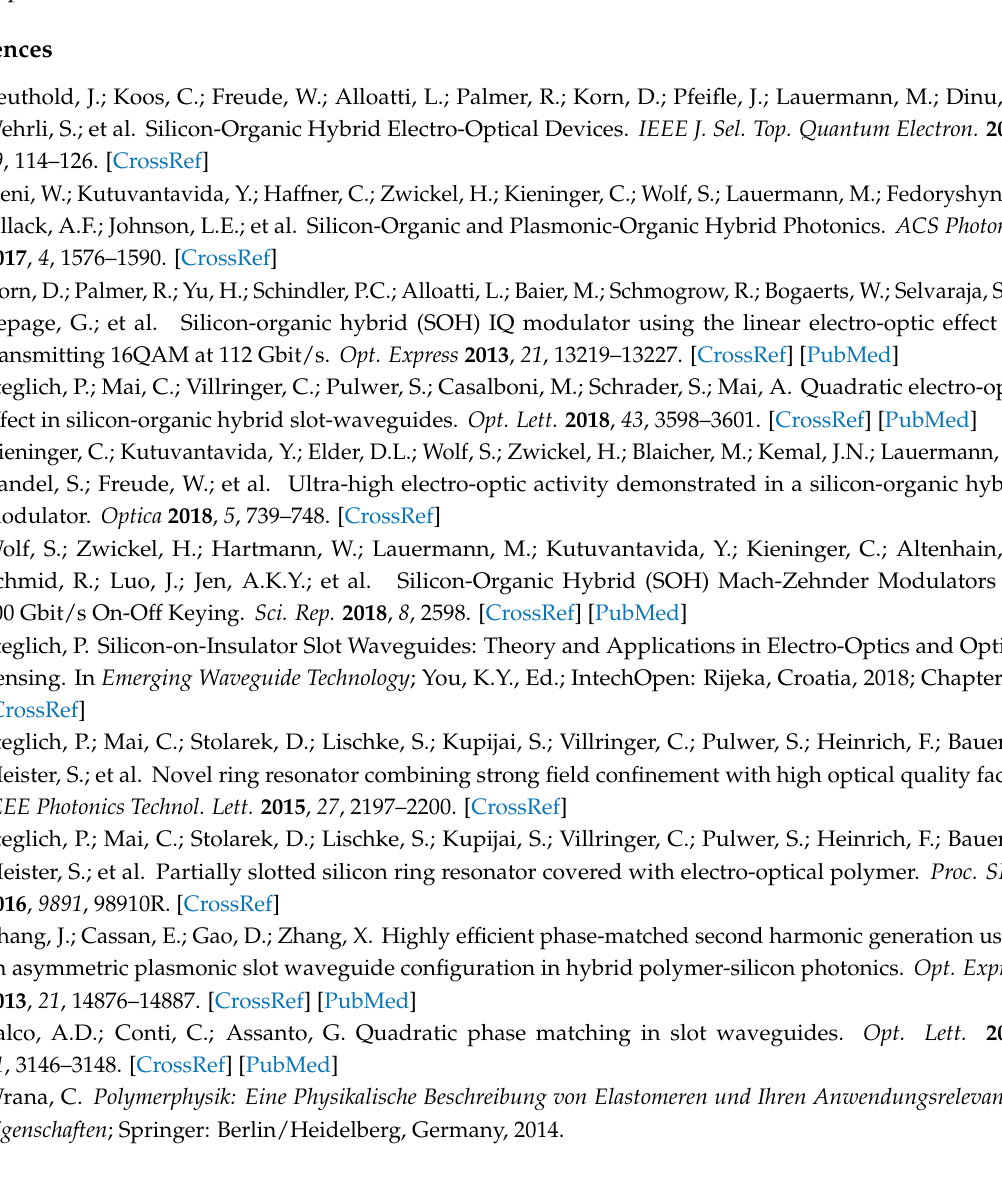
Figure A6. Field confinement factor Γ slot for both concentrations as a function of s and with h as